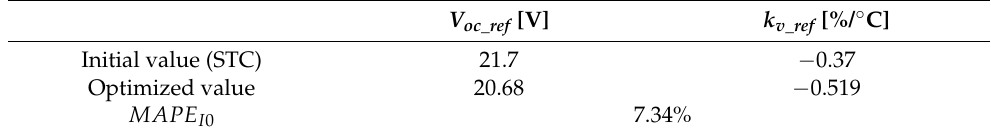
Table 6. Extracted reference values. Table 6 . Extracted reference values .